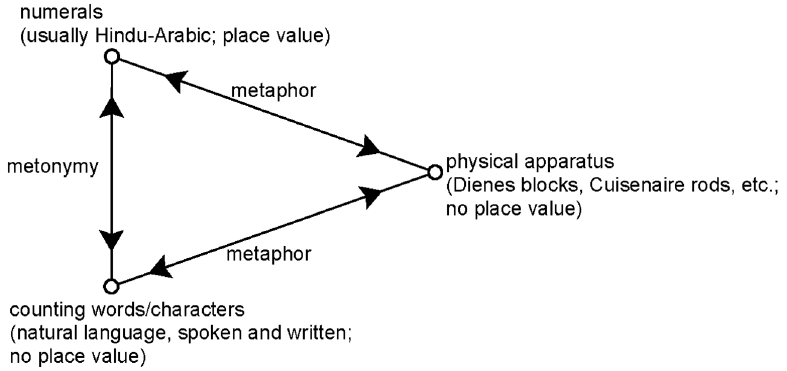
Figure 1. Reproduced from Pimm